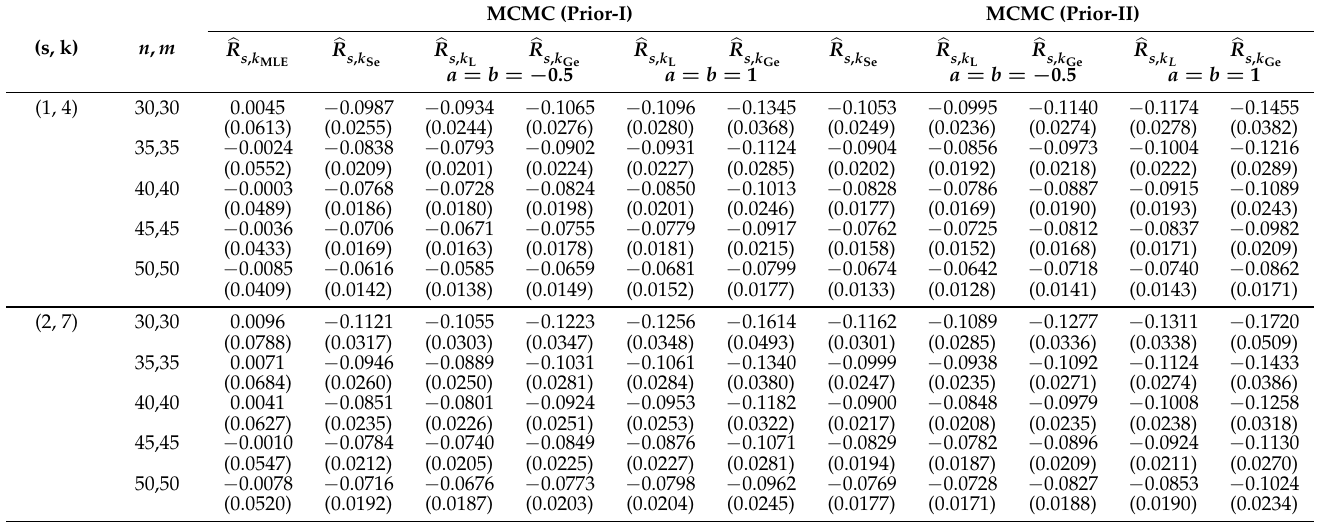
Table 3. The rBias and rMSE (in parentheses) for Case 1, ( α , λ 1 , β , λ 2 ) = ( 1.5, 1, 2, 1 ) and T = 1.